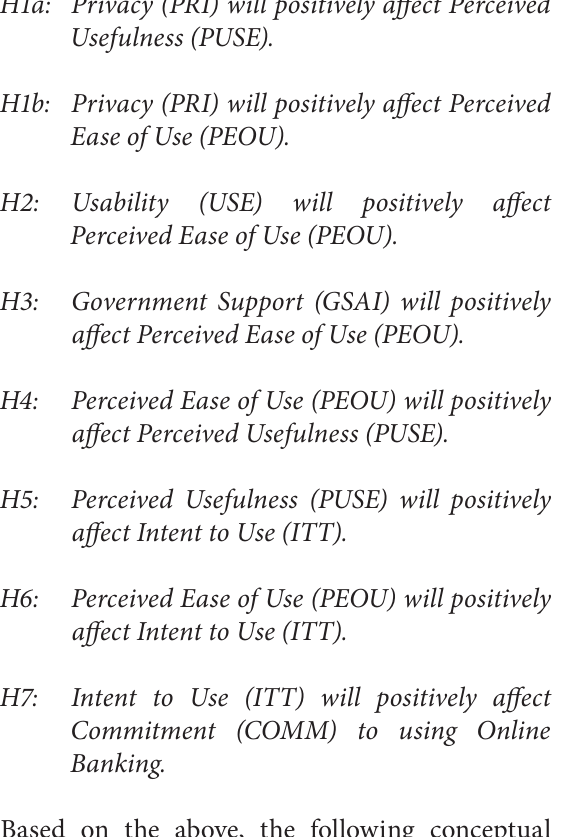
Figure 1. Proposed hypothesized conceptual framework